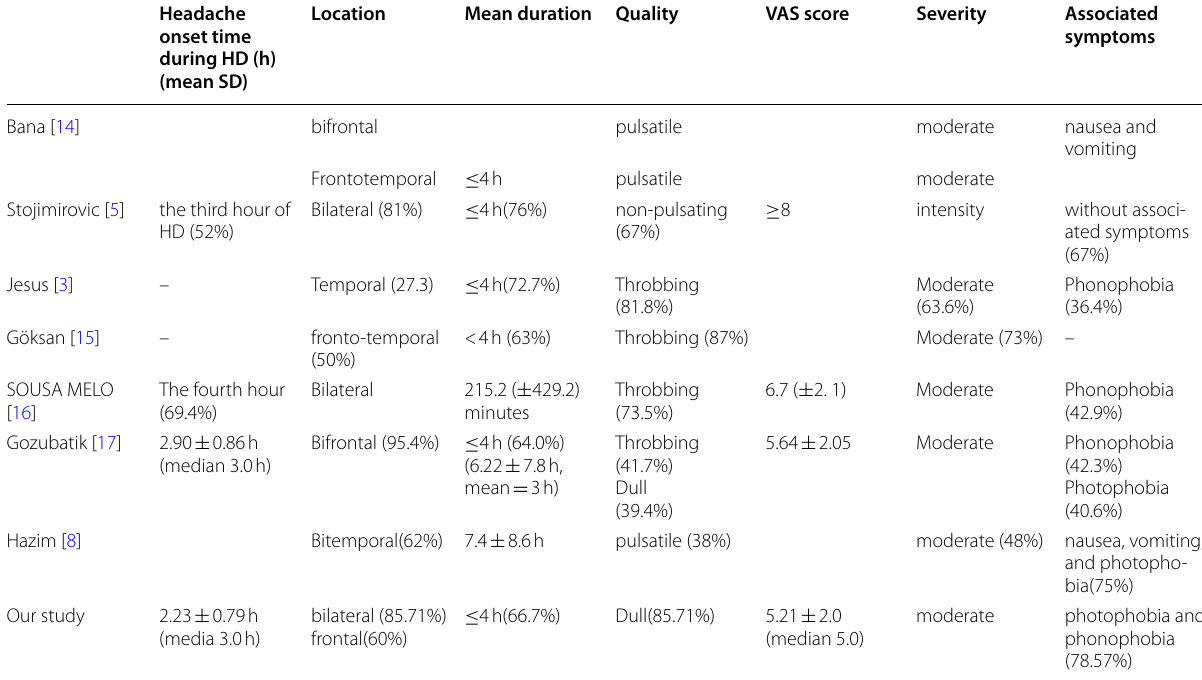
Table 4 The characteristic of HDH in previous and our study